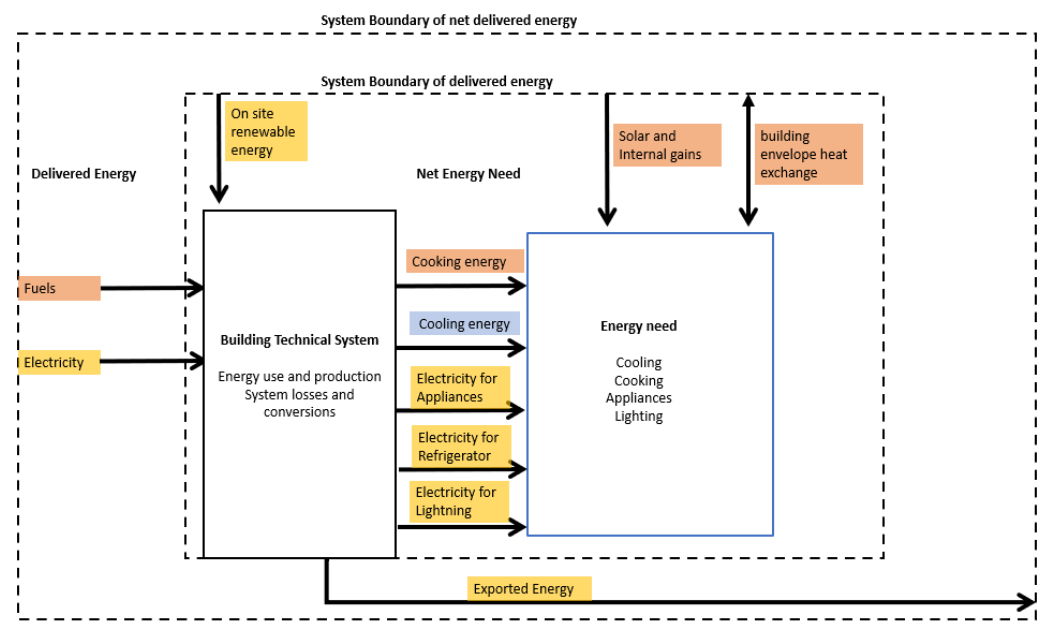
Figure 10. System Boundary (adapted from [22]).